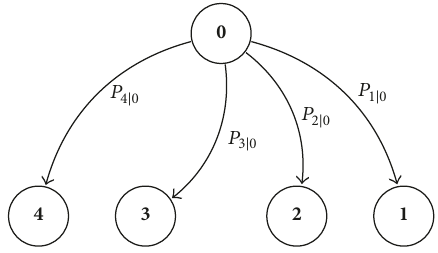
Figure 12: Start state of the rover position accuracy.